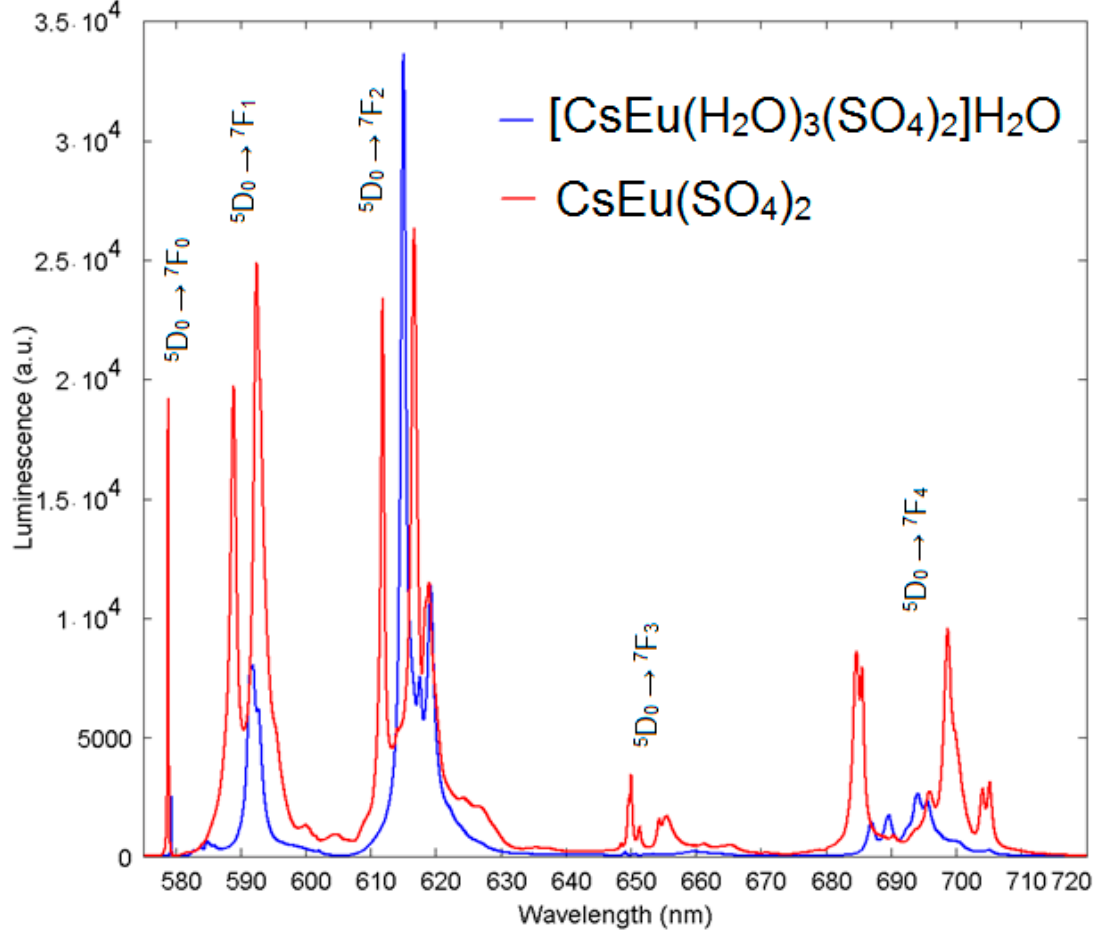
Figure 13. Emission spectra of [CsEu(H 2 O) 3 (SO 4 ) 2 ]·H 2 O (blue) and CsEu(SO 4 ) 2 (red).